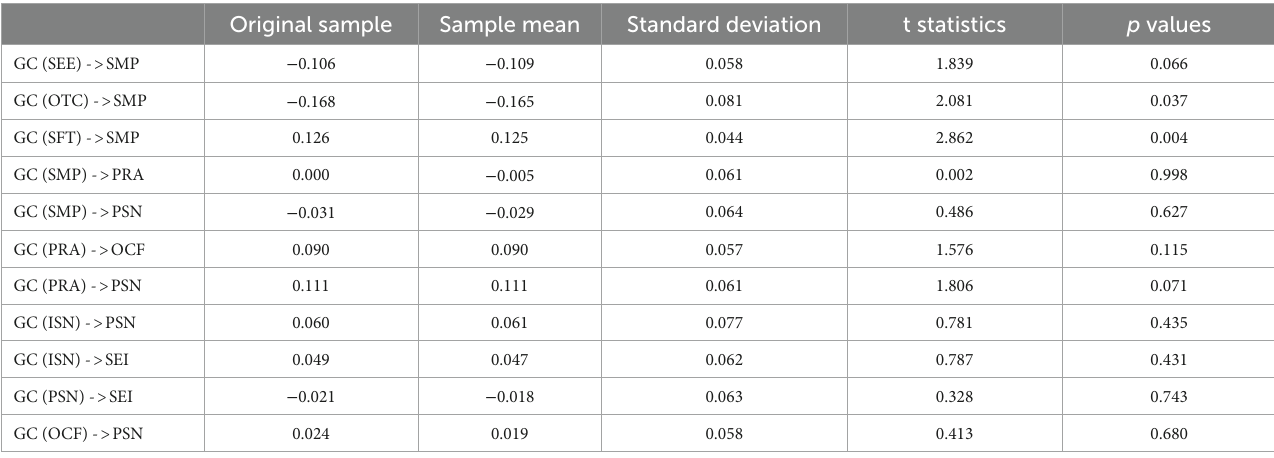
TABLE 6 Gaussian Copula tests.